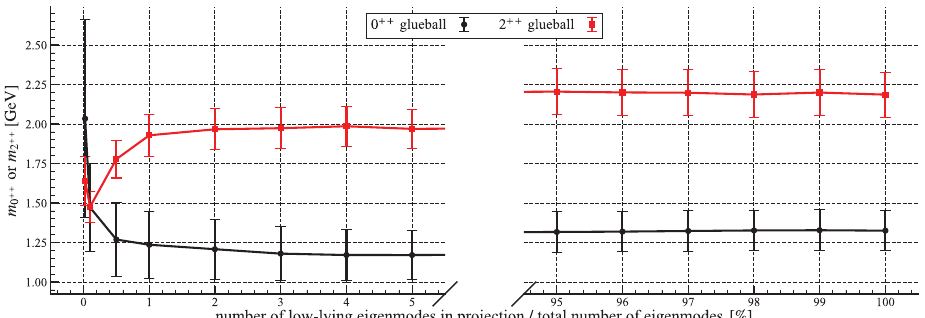
Figure 4. Glueball masses under the eigenmode projection in GeV unit plotted against the number of low-lying FP eigenmodes in the projection.